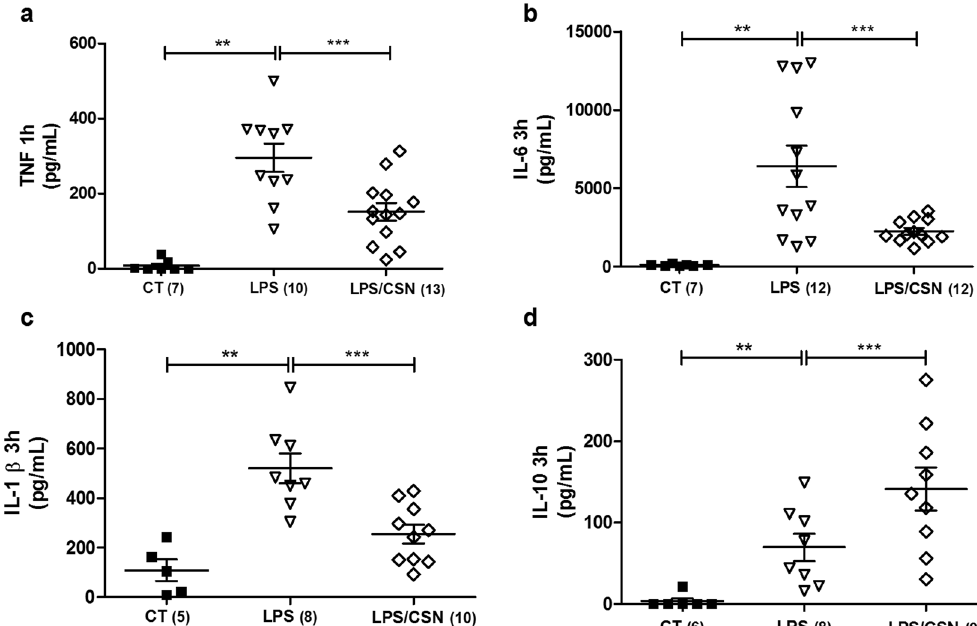
Figure 2. Effect of electrical stimulation of the carotid sinus nerve (CSN) on plasma cytokines concentration in LPS induced systemic inflammation in conscious rats. Panel a : TNF ( ** p < 0.001 vs Control, *** p = 0.002 vs LPS) 1 hour after LPS administration. Panels b , c , and d, respectively : IL-6 ( ** p < 0.001 vs Control, *** p = 0.007 vs LPS ), IL-1 β ( ** p < 0.001 vs Control, *** p = 0.005 vs LPS ), and IL-10 ( ** p < 0.001 vs Control, *** p = 0.0019 vs LPS ) 3 hours after LPS administration. Number of animals is shown between parentheses.